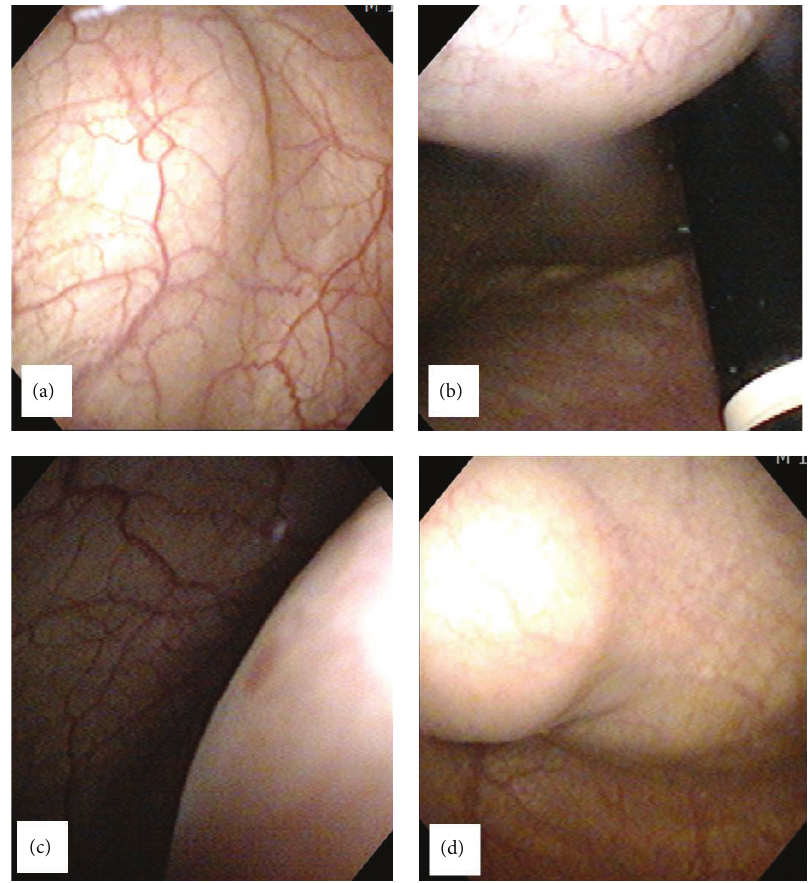
Figure 2: Cystoscopy shows a ball-shaped extrinsic mass from the bladder dome with intact bladder mucosa.